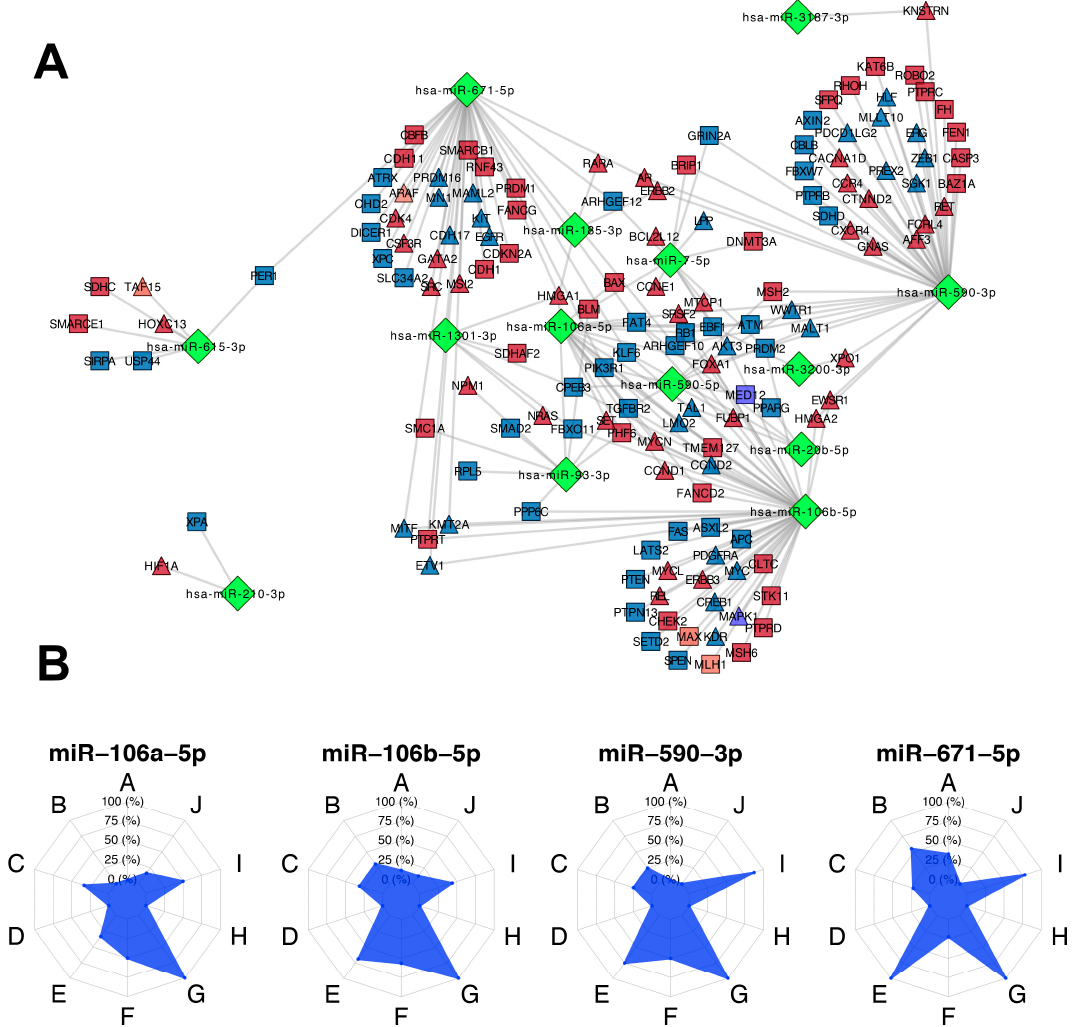
Figure 6. The 14 oncogenic miRNA master regulators (OncoMMRs) with a positive contribution to the tumoral phenotype and their driver targets. ( A ) The OncoMMR network where miRNAs are depicted as green diamonds, oncogenes as triangles and tumor suppressor genes as rectangles; blue and red represent downregulated and overexpressed genes, respectively. ( B ) Radar plots show the enrichment of genes as per the hallmark for the top four most highly connected OncoMMRs, where